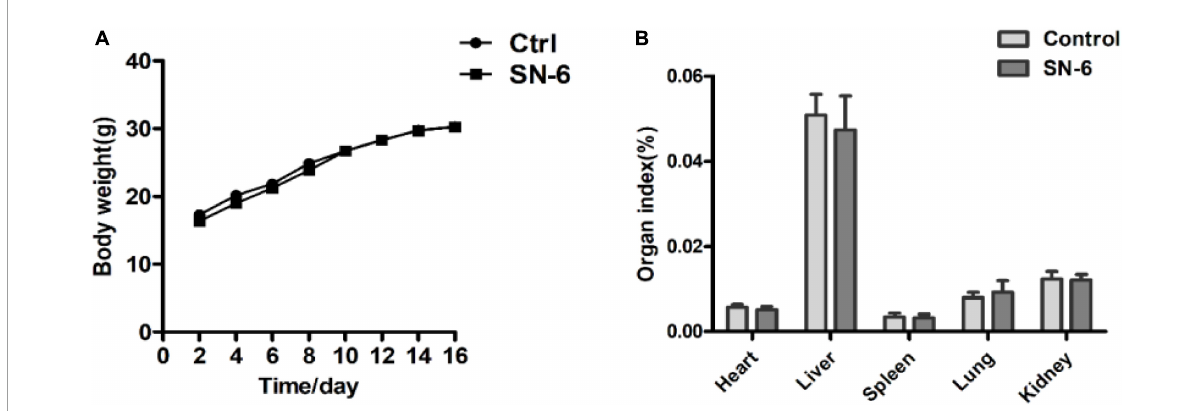
FIGURE2 Body weight and organ index of mice in the control and SN-6 treated groups. The values are presented as the mean ± SD ( n = 10). (A) Body weight and (B) organ index.